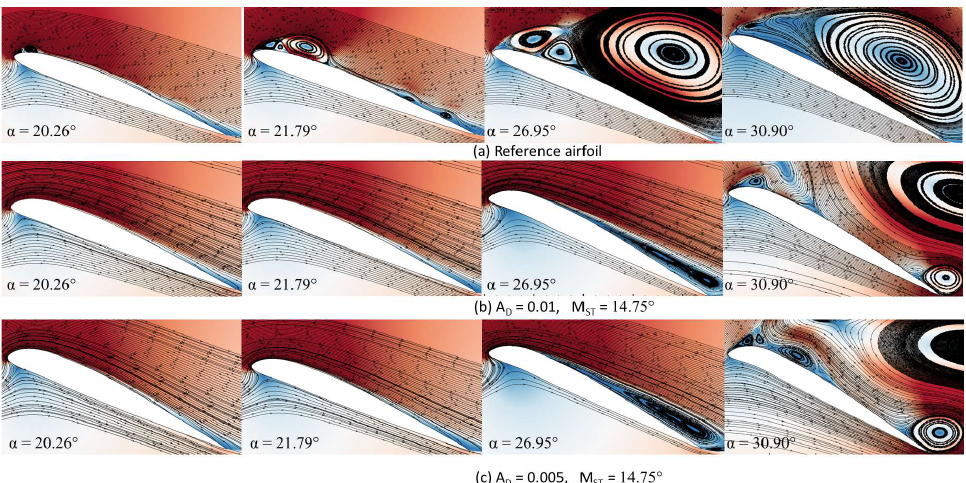
Figure 13. Velocity contours with flow streamlines for the ( a ) reference airfoil, ( b ) DMLE airfoil with 𝐴 (cid:3005) = 0.01 and ( c ) DMLE airfoil with 𝐴 (cid:3005) =